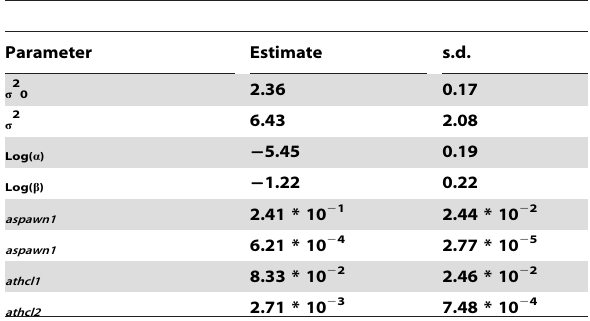
Table 1. Larvae model parameter estimates.